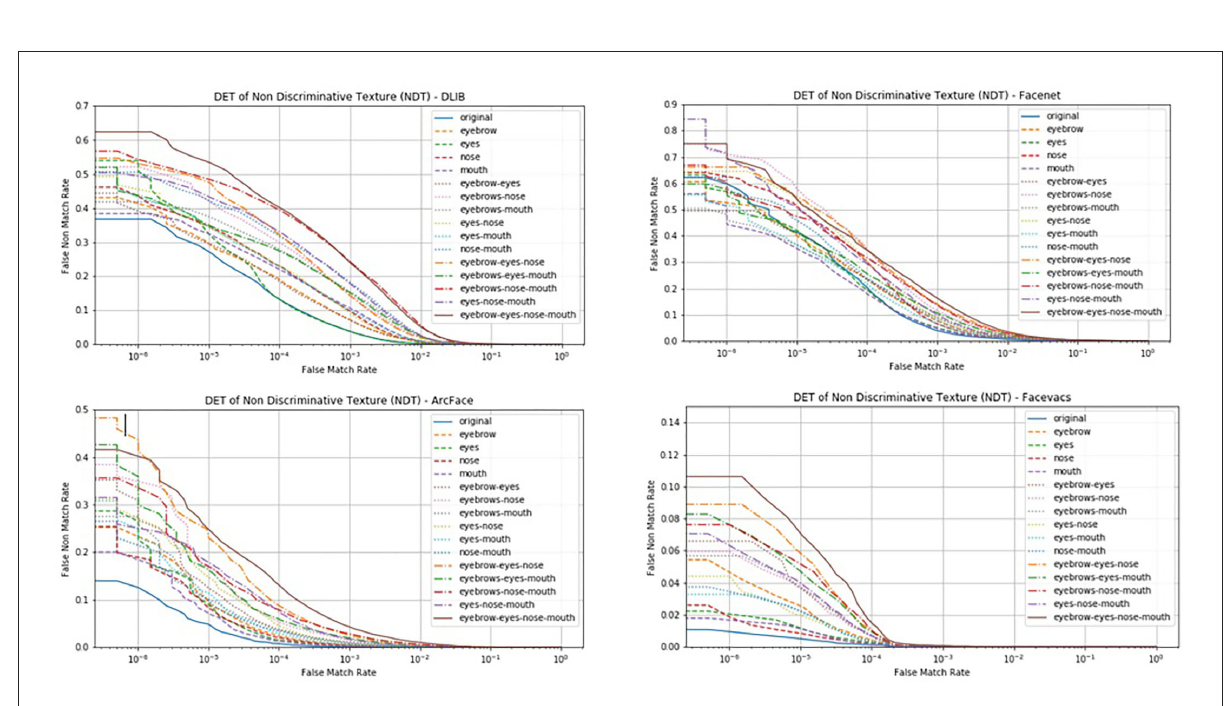
FIGURE5 Face part analysis of NDT experiment using